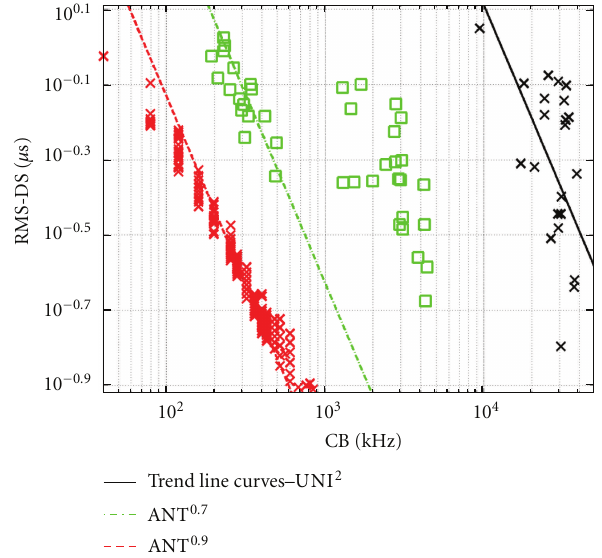
Figure 7: Scatter plot of RMS-DS versus CB for the simulated channels—overhead HV/BPL networks for the propagation of DM 4 and coupling scheme WtW 1 − 2 —(black × ), measured channels— cruise ship LV/BPL power networks ( (cid:2) ) and indoor LV/BPL power networks (red × )—, and trend line curves—UNI 2 ( — ), ANT 0 . 7 ( - · ), and ANT 0 . 9 ( - - ) approaches (logarithmic scale was used for the x - and y